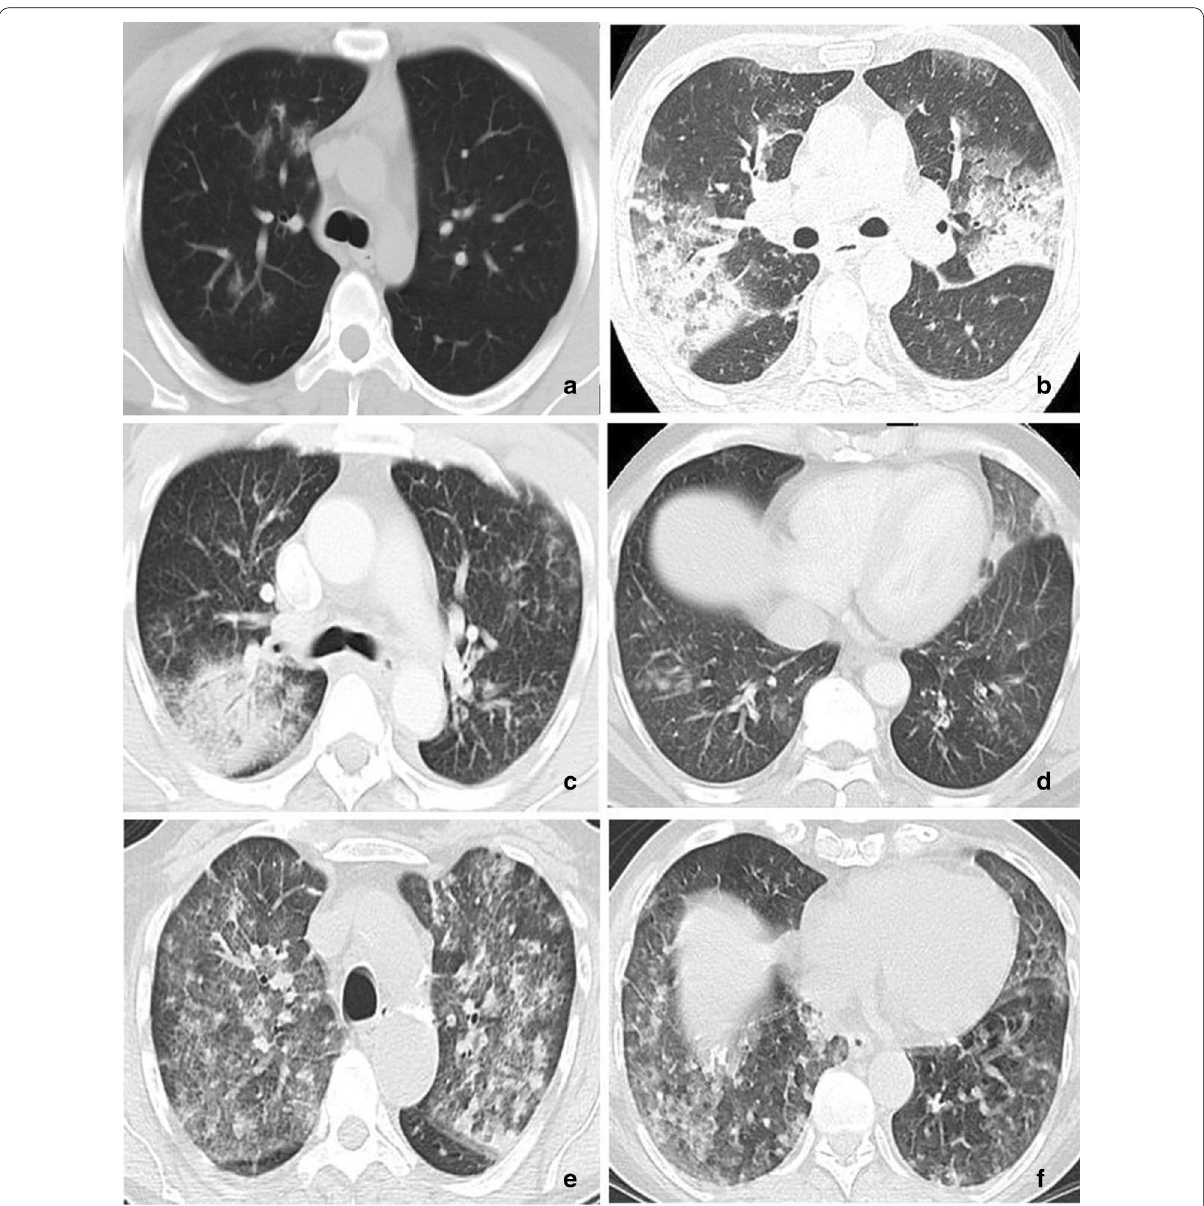
Fig. 7 Indeterminate COVID‑19 and viral pneumonia mimickers. a , b Indeterminate CT features for COVID‑19 in two different patients with positive RT‑PCR test, axial CT images show unilateral small areas of non‑peripheral GGO ( a ) and bilateral multifocal non‑rounded GGO of non‑specific distribution ( b ). c , d Adenovirus pneumonia in a 48‑year‑old man, axial CT images show bilateral area of consolidation with nearby GGO and bilateral centrilobular nodules. e , f HSV pneumonia in a 75‑year‑old woman, axial CT images show widespread bilateral GGO of non‑rounded morphology, small areas of consolidation and diffuse interlobular septal